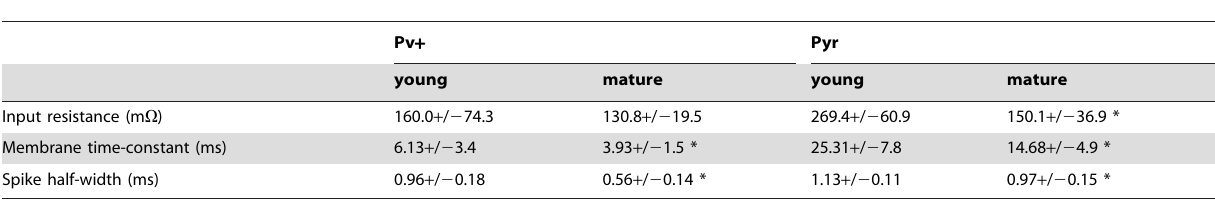
Table 2. Intrinsic properties of layer 2/3 neurons of